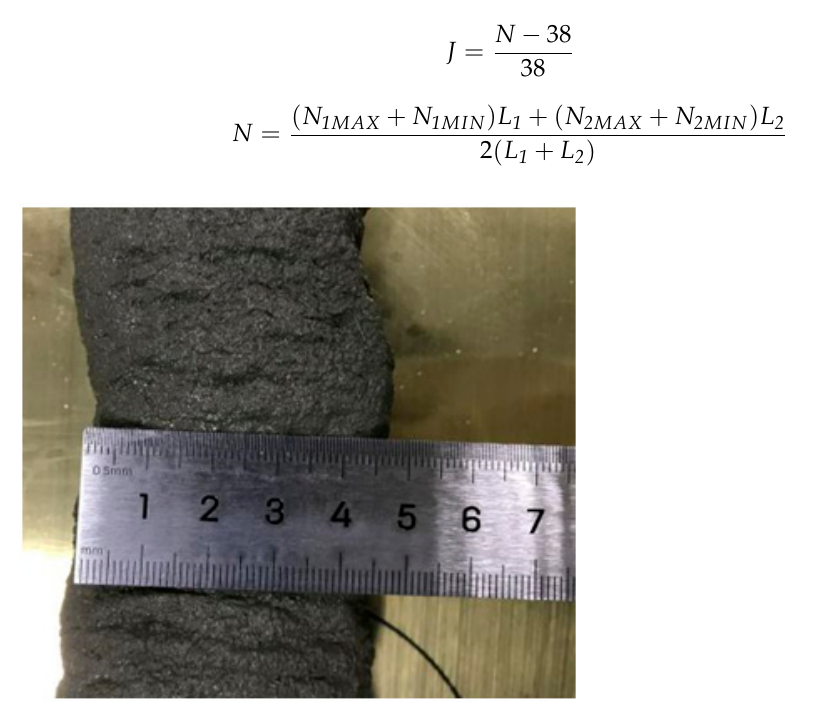
Figure 6. Measure printable filament width.